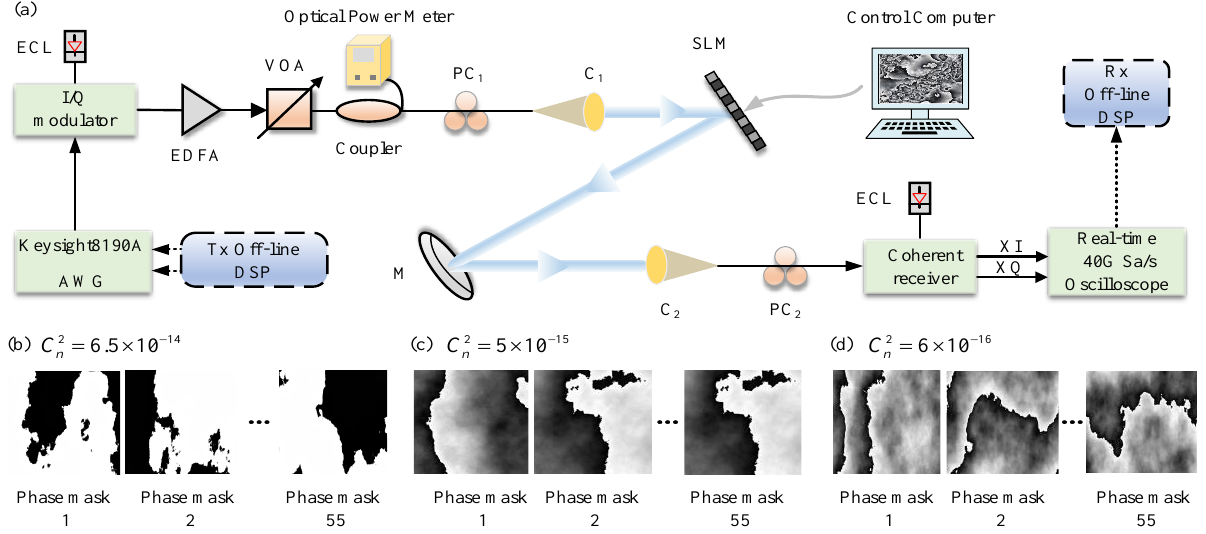
Figure 9. Experimental setup for a 10 Gbps QPSK CFSO transmission system. ECL: external cavity laser; PC: polarization controller; C: collimator; M: mirror; SLM: space light modulator. ( a ) QPSK CFSO communication experiment system diagram. ( b ) Grayscale map of strong-turbulence channel. ( c ) Grayscale map of medium-turbulence channel. ( d ) Grayscale map of weak-turbulence